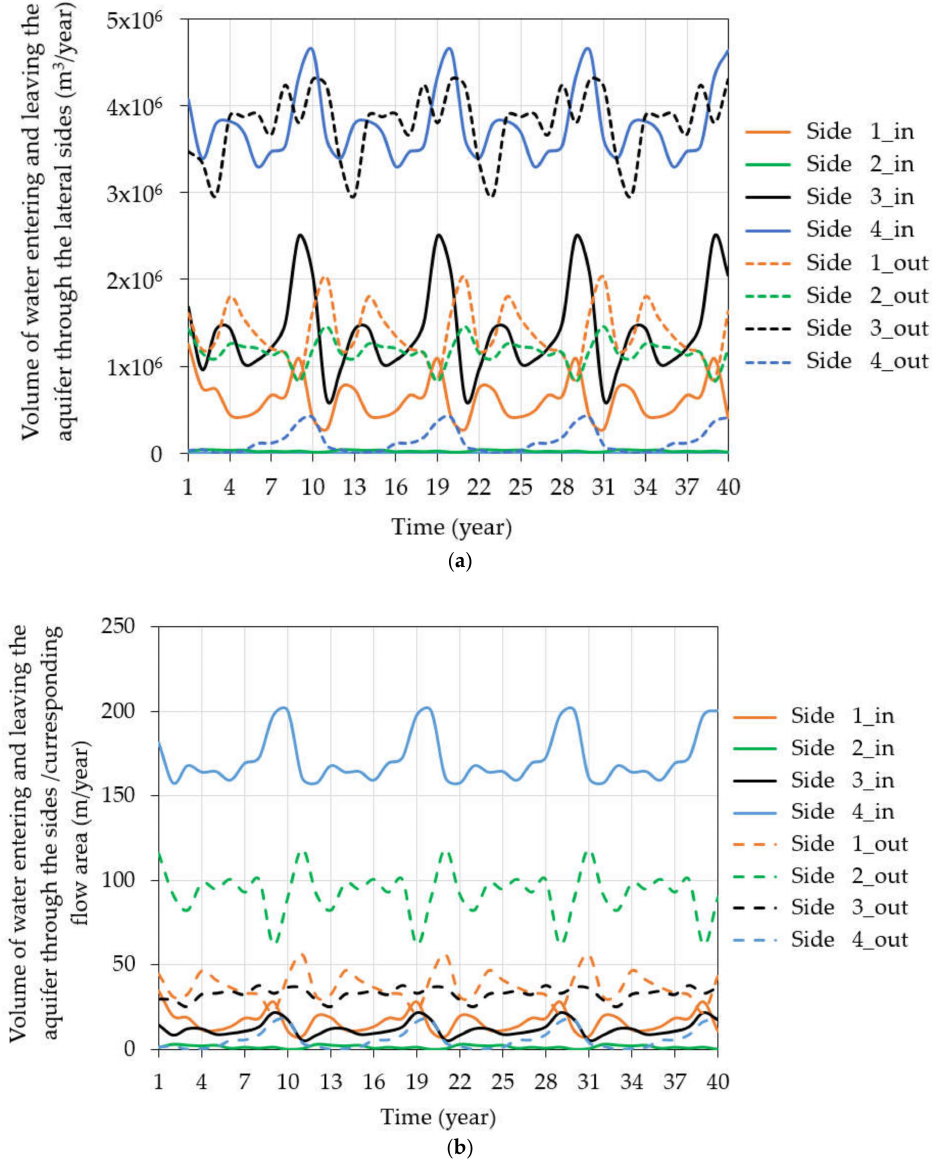
Figure 10. Volumes of water entering and leaving through sides of the domain ( a ), and water fluxes entering and leaving the aquifer through sides of the domain ( b ), (Side 1_in to Side 4_in represent flow entering through particular lateral sides, and Side 1_out to Side 4_out represent flow leaving through particular lateral